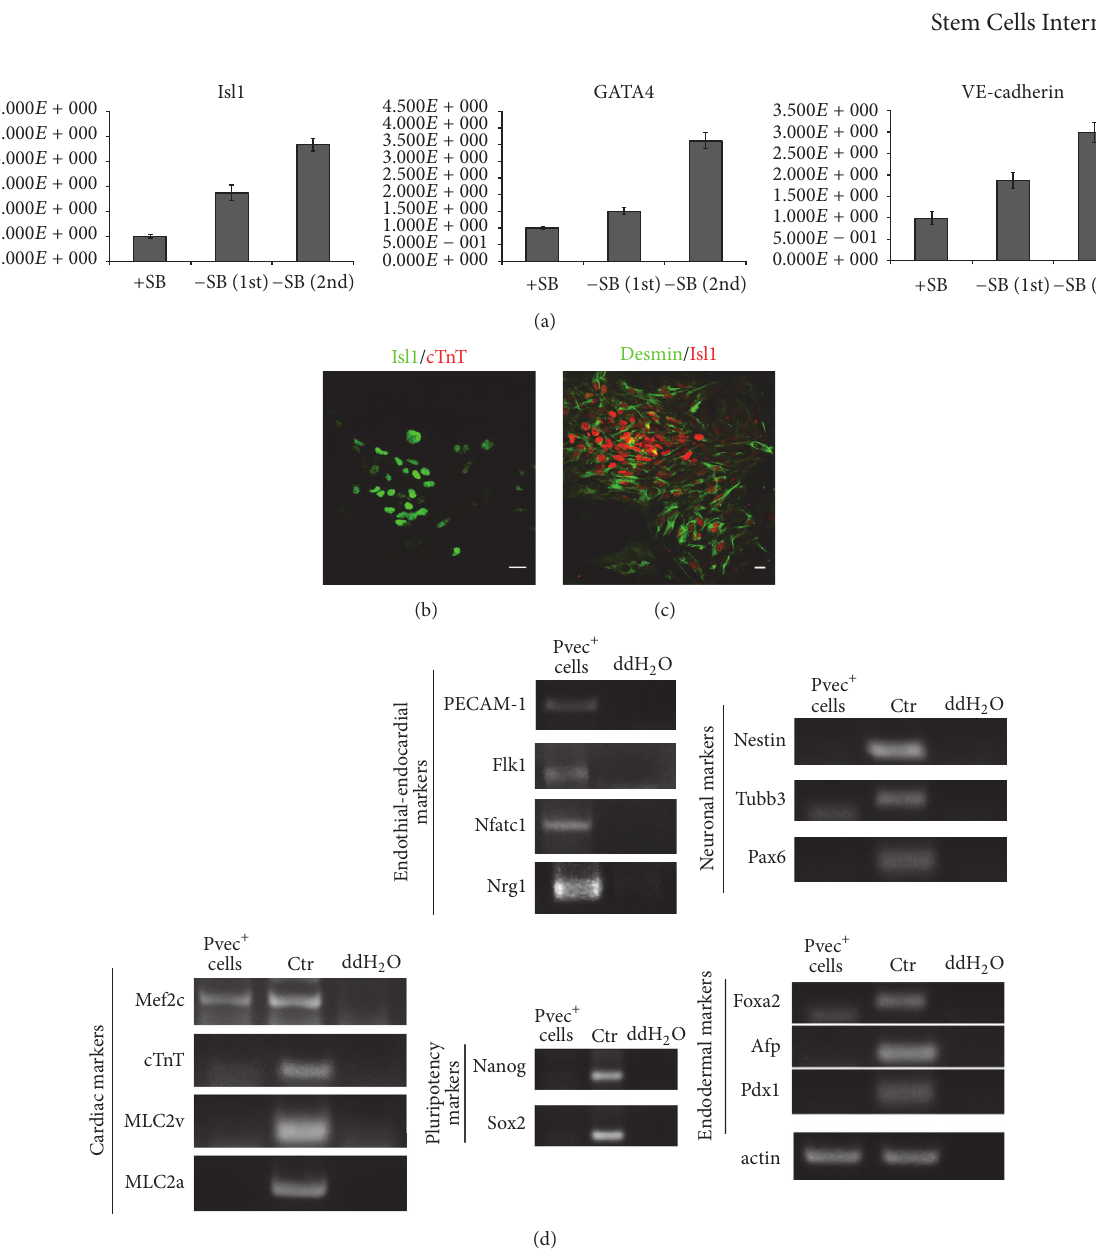
Figure 4: Characterization of Pvec + cells. (a) Isl1, GATA4, and VE-cadherin mRNA levels quantification in Pvec + cells in the presence or absenceofSB-216763byrealtimeqPCR.Resultsin-SBfirstand-SBsecondreferredtotwoindependentselection/differentiationexperiments. (b-c)Isl1 + cardiacprogenitorsexpressdesminbutnotcTnT,amarkerofdifferentiatedcardiomyocytes.(d)RT-PCRanalysisofexpandedPvec + cells showed expression of cardiac, endothelial, and endocardial but not neuroectodermal, endodermal, or pluripotency markers. As positive controls (ctr) mRNA from E14T ESCs differentiation was used. Note the lack of cTnT, MLC2v, and MLC2a expression in expanded Pvec + cells. Scale bar: 20 𝜇